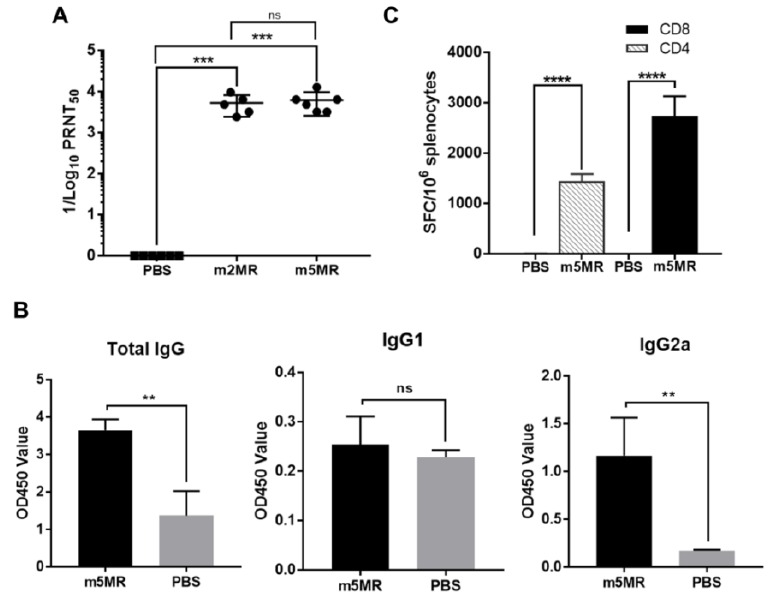
Figure 6. Humoral and cell-mediated immune responses in mutant virus-infected animals. ( A ) The viral neutralization titers in serum [expressed as reciprocal of 50% plaque reduction neutralization test (PRNT 50 ) values] from PBS-treated or m2MR- or m5MR-infected animals at 28 dpi. ( B ) Antibody isotyping in sera by ELISA for PBS-injected or m5MR virus-infected mice. ( C ) The spleen from m5MR virus-infected ( n = 5) or PBS-injected ( n = 4) A129 animals were collected at 28 dpi, and the cells were stimulated with ZIKV E specific peptides for CD4 + and CD8 + T cells. ELISPOT was performed to determine spot-forming cells (SFC) per million splenocytes. Mann–Whitney test (for panel ( A , B )) and Unpaired Student’s t -test (two-tailed) (for panel ( C )) were used to determining significance between groups. ****, p < 0.0001; ***, p < 0.001; **, p < 0.01; ns, non-significant.